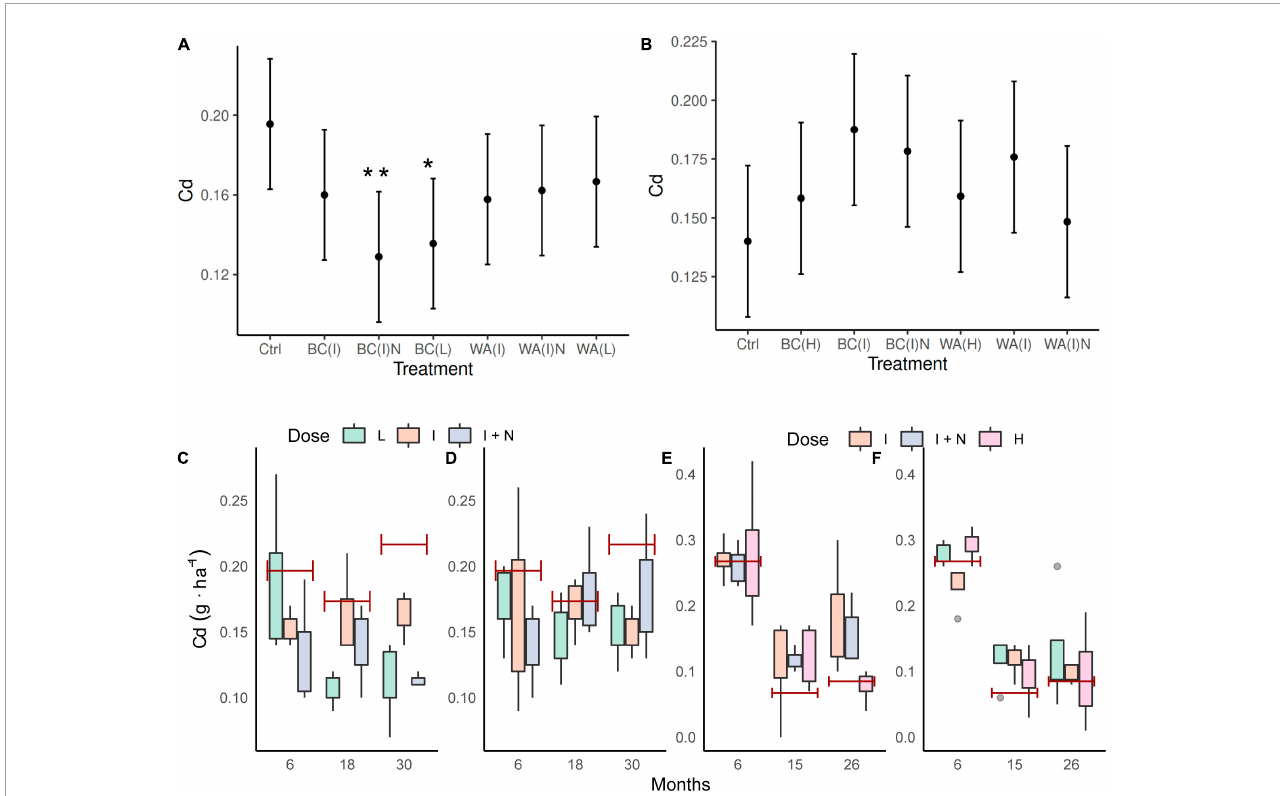
FIGURE3 Estimated Marginal Means (EMM) of Cd content (g · ha − 1 ) in soil (top) in ES-K soil (A) and in ES-O (B) , and boxplots showing Cd content in soil at each experimental site: ES-K (C,D) and ES-O (E,F) during the time (X-axis). Values for biochar (BC) treatments are represented by boxplots c and e, and wood ash (WA ) treatments are represented by boxplots (D,F) . EMM of control is represented in the boxplots by red lines, to provide a visual comparison. High dose (H, purple), intermediate dose (I, pink) and low dose (L, green); 0.8% of N (always with intermediate rate), (N, blue). Boxes show the density data within the first to the third quartile of the dataset for each treatment. The upper and lower whiskers extend from the higher to the lower Cd content data. Means which differ significantly from control are in bold and mark with asterisks (* p < 0.05; ** p >